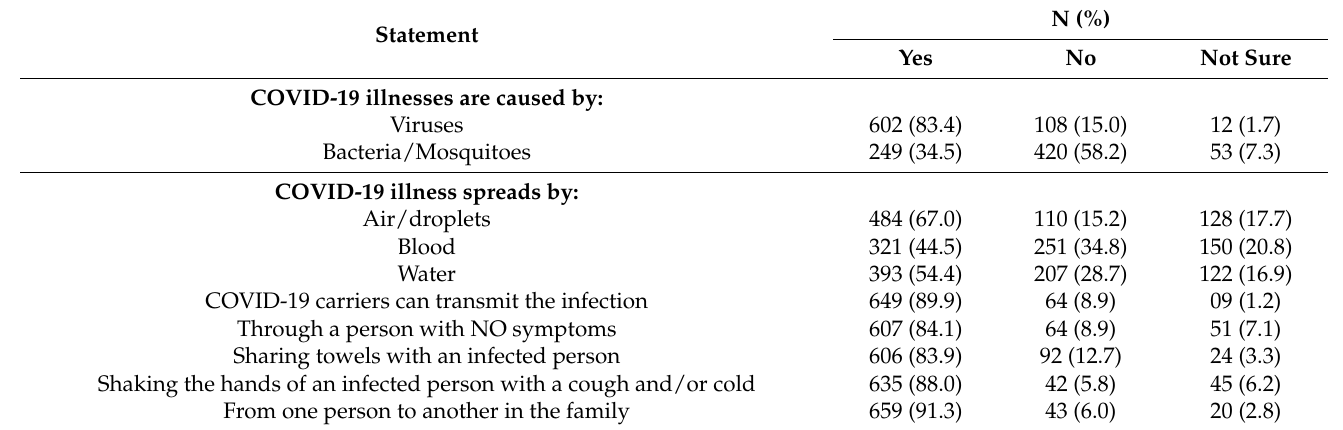
Table 3. Responses to the questionnaire on COVID-19